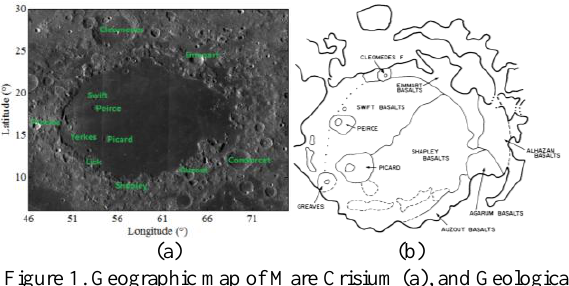
Figure 1. Geographic map of Mare Crisium (a), and Geological units map (Head et al. 1978) (b). Note:WAC map was download from